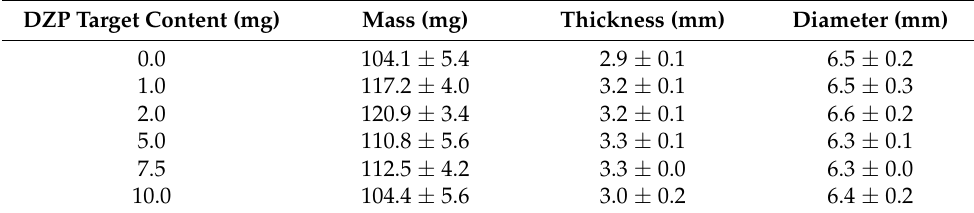
Table 2. Mass, thickness and diameter ( n = 10) of placebo and diazepam (DZP)-loaded